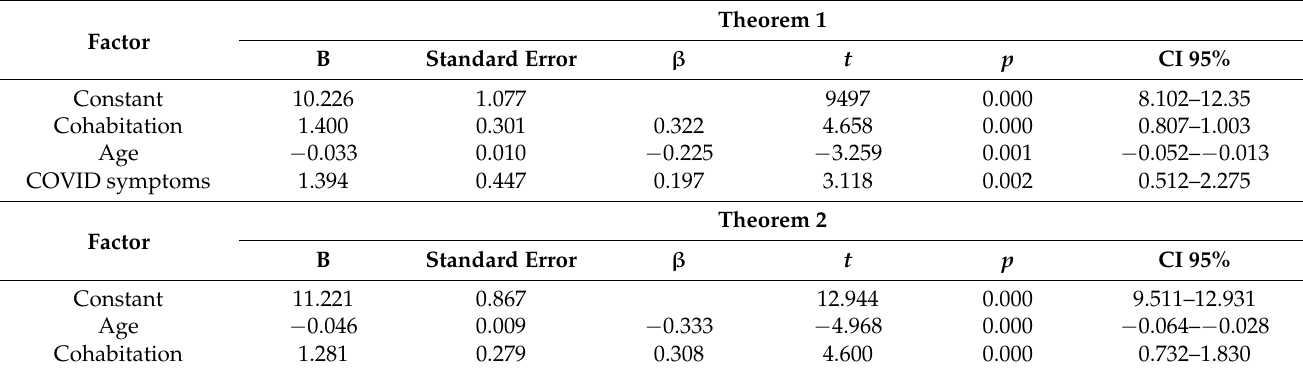
Table 5. Models of regression analysis. Theorem 1 and Theorem 2 ( N = 808), Spain,